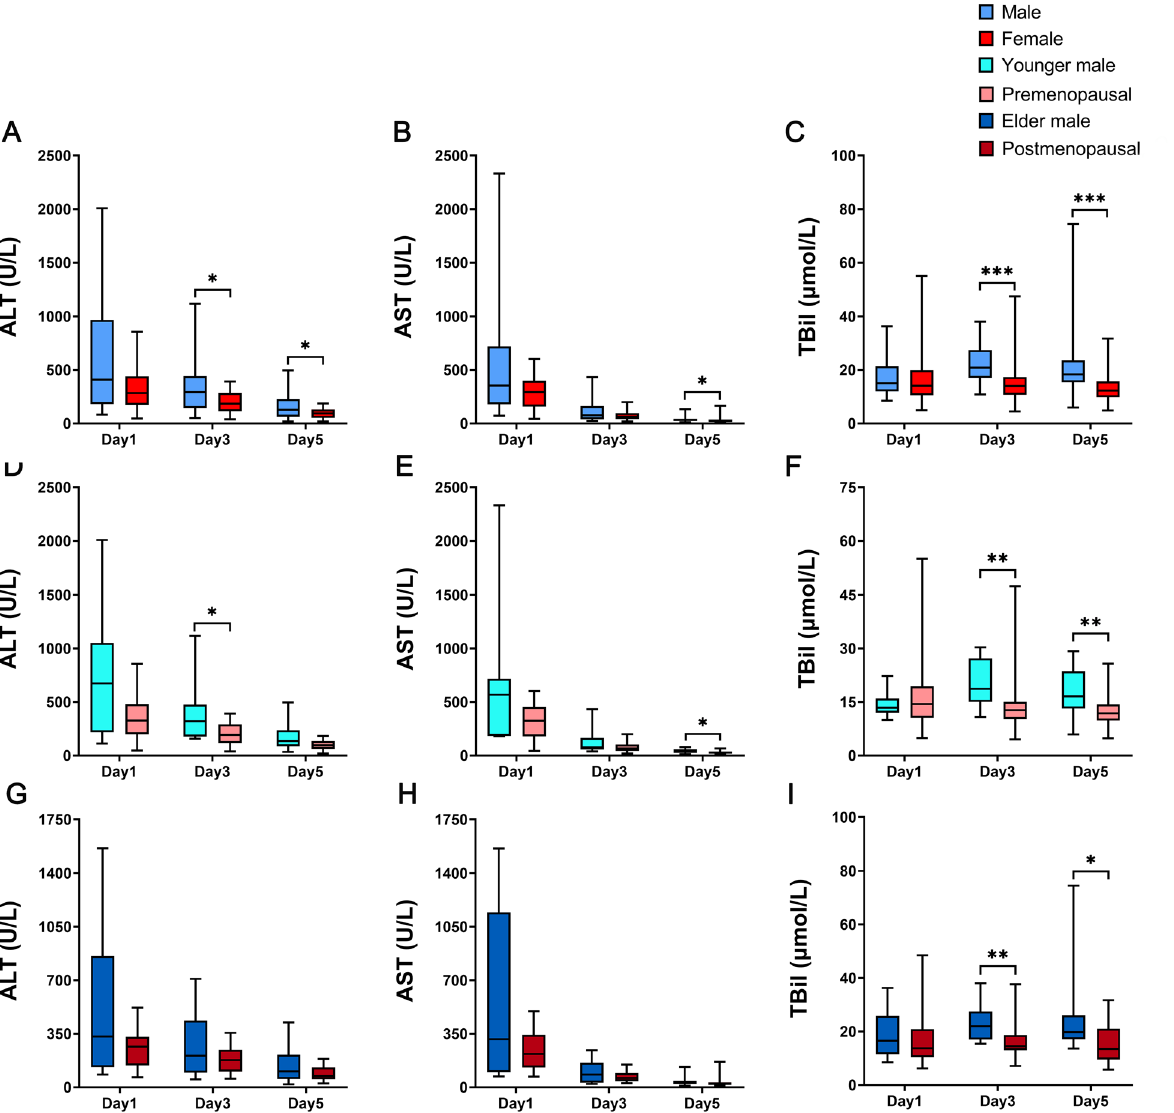
Figure 2. Comparison of liver function. ( A ) ALT between male group and female group. ( B ) AST between male group and female group. ( C ) TBil between male group and female group. ( D ) ALT between younger male group and premenopausal group. ( E ) AST between younger male group and premenopausal group. ( F ) TBil between younger male group and premenopausal group. ( G ) ALT between elder male group and postmenopausal group. ( H ) AST between elder male group and postmenopausal group. ( I ) TBil between elder male group and postmenopausal group (* P < 0.05, ** P < 0.01, *** P <